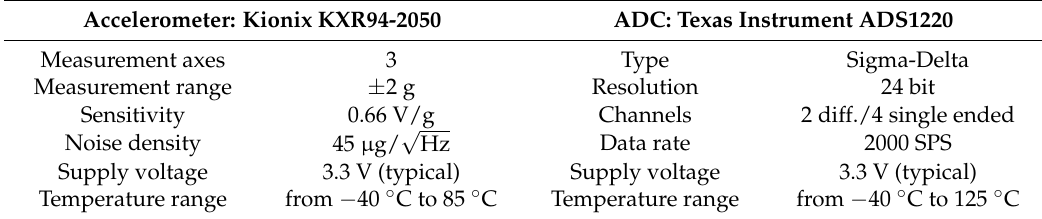
Table 1. Electrical properties for the chosen accelerometer and